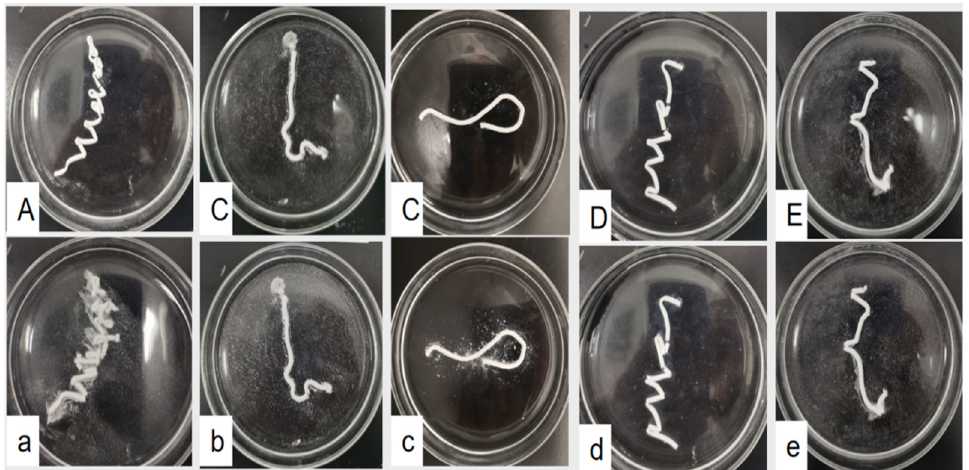
Figure 7. Anti-washout properties of the composite bone cement with different PLGA–PEG–PLGA temperature-sensitive hydrogel contents: ( A – E ) photos of as-prepared 0, 10, 20, 30, and 40% v / v PLGA–PEG–PLGA/C 3 S/C 2 S/POP bone cement slurry injected into SBF solution at 37 °C, respectively; ( a – e ) corresponding photos after shaking using a horizontal rotary oscillator for 1 min.